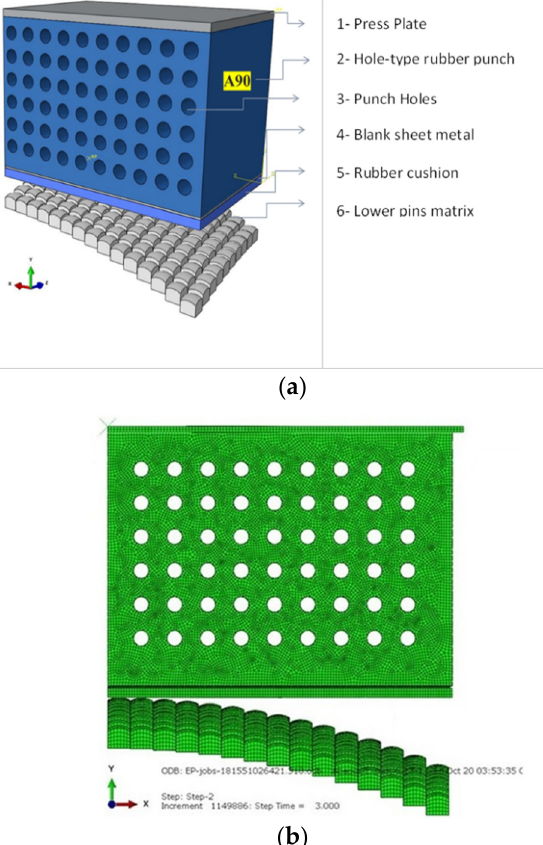
Figure 2. ( a ) The model setup; ( b ) the model Mesh .